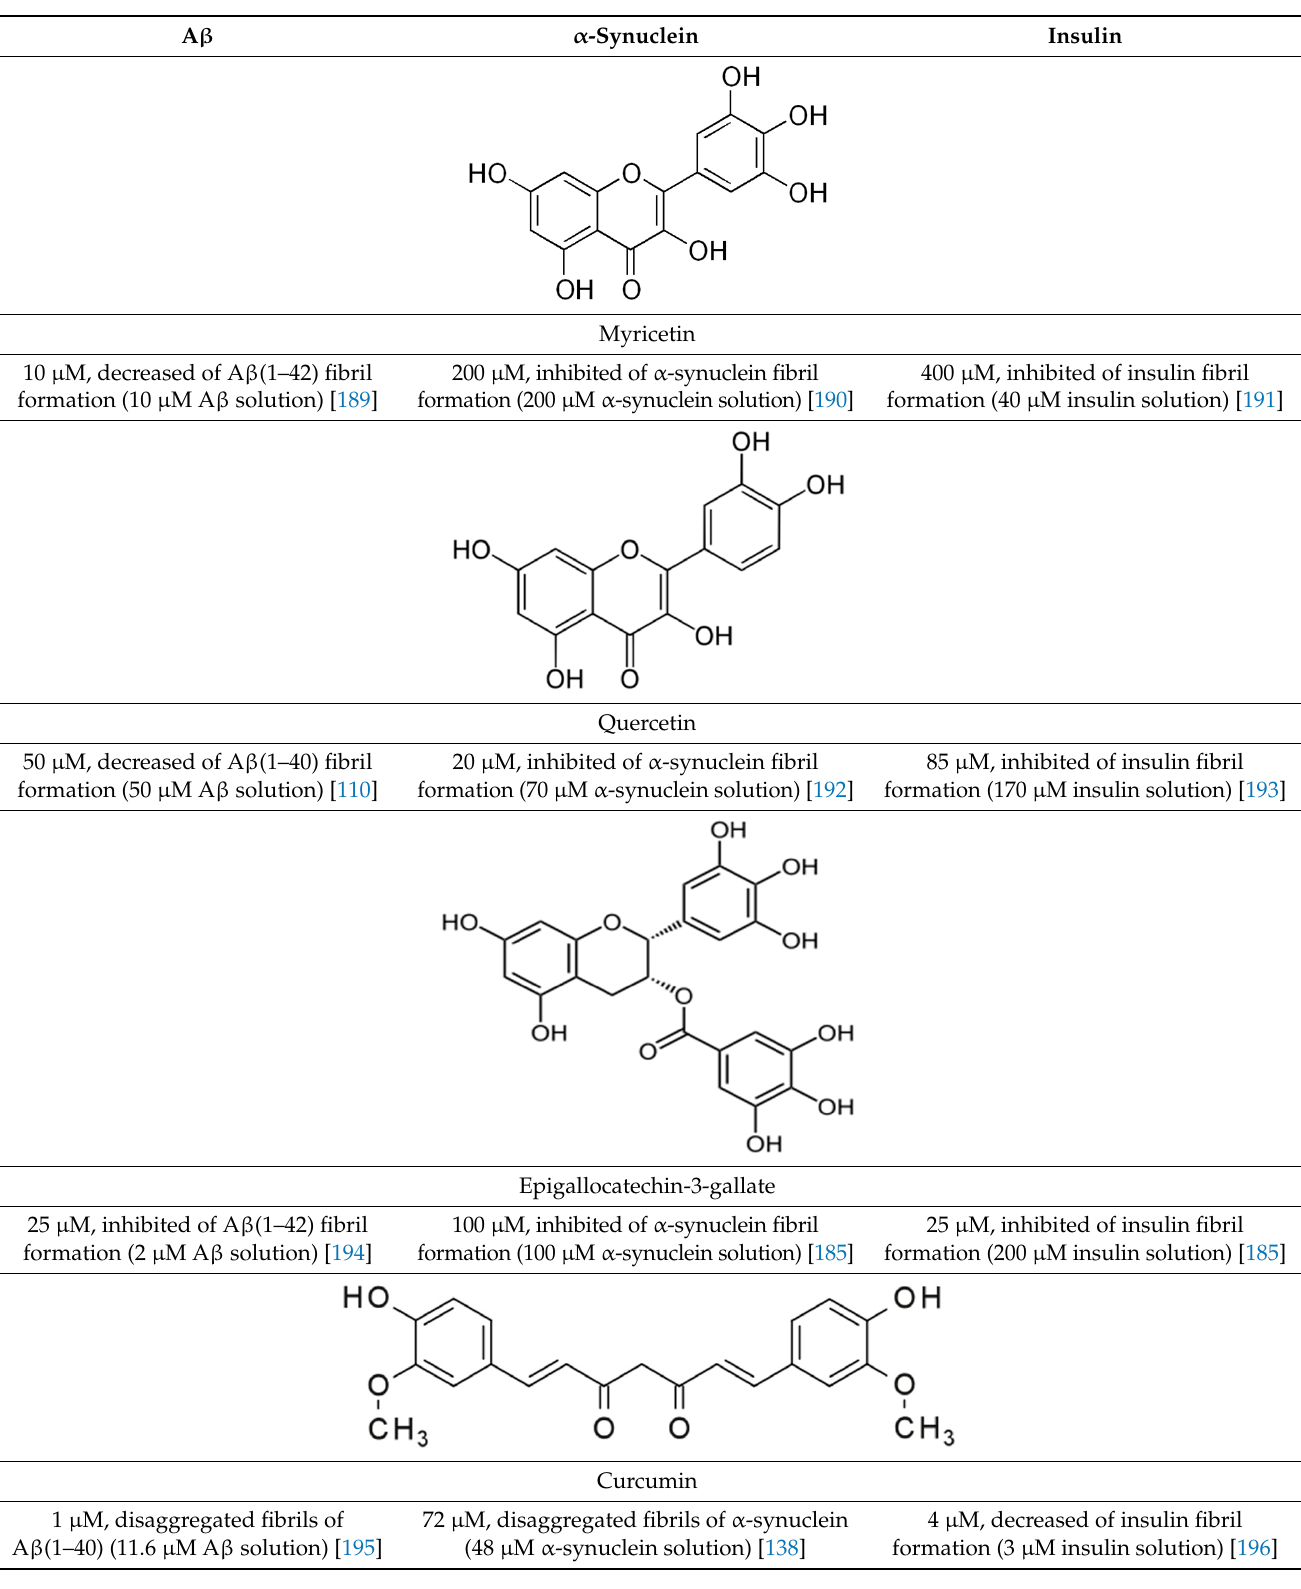
Table 1. Common inhibitors for A β , α -synuclein, and insulin.